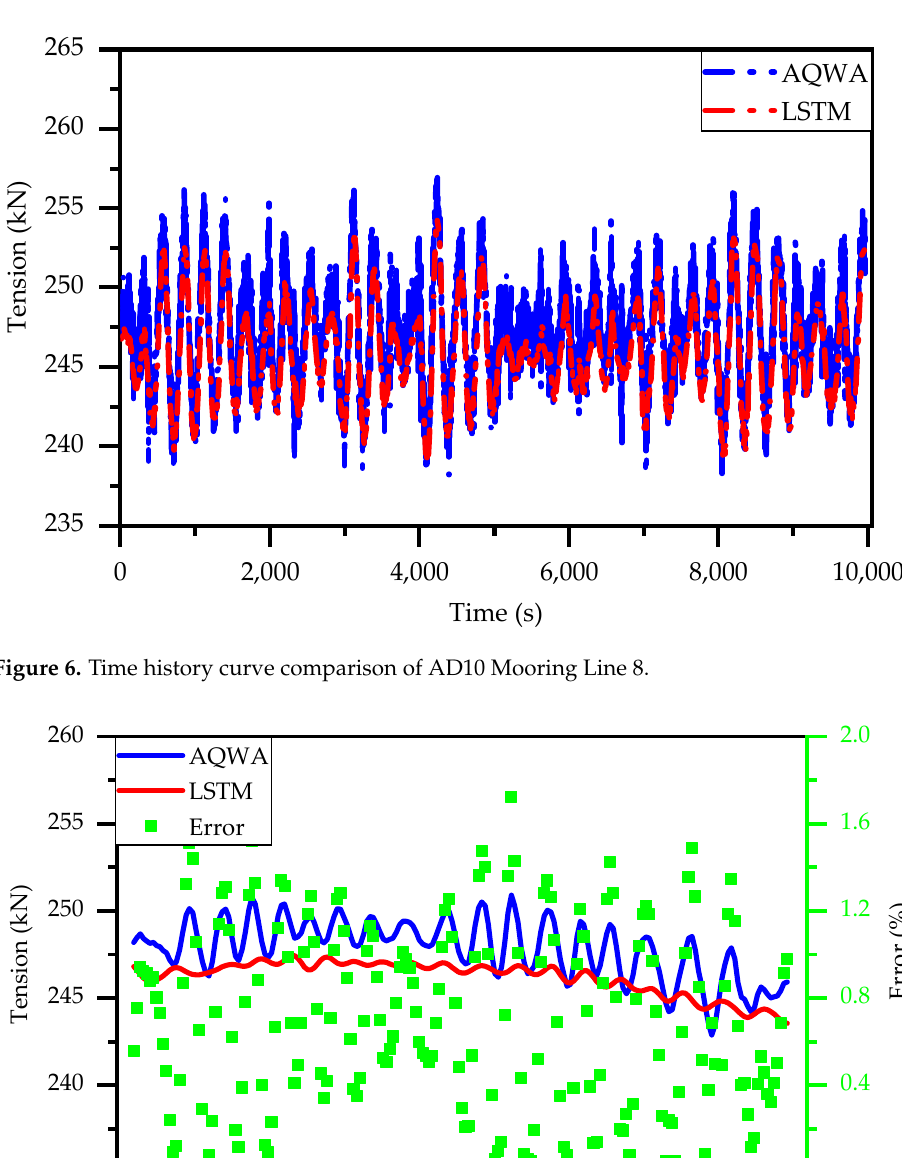
Figure 8. Time history curve comparison of AD7 Mooring Line 7.